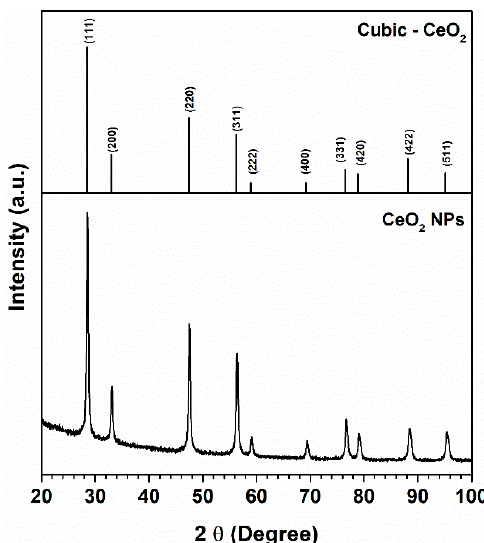
Figure 4. XRD patterns for CeO 2 NP. The vertical bars correspond to the diffraction peaks attributed to CeO 2 cubic phase (ICDDPDF file no. 00 ‐ 067 ‐ 0123).